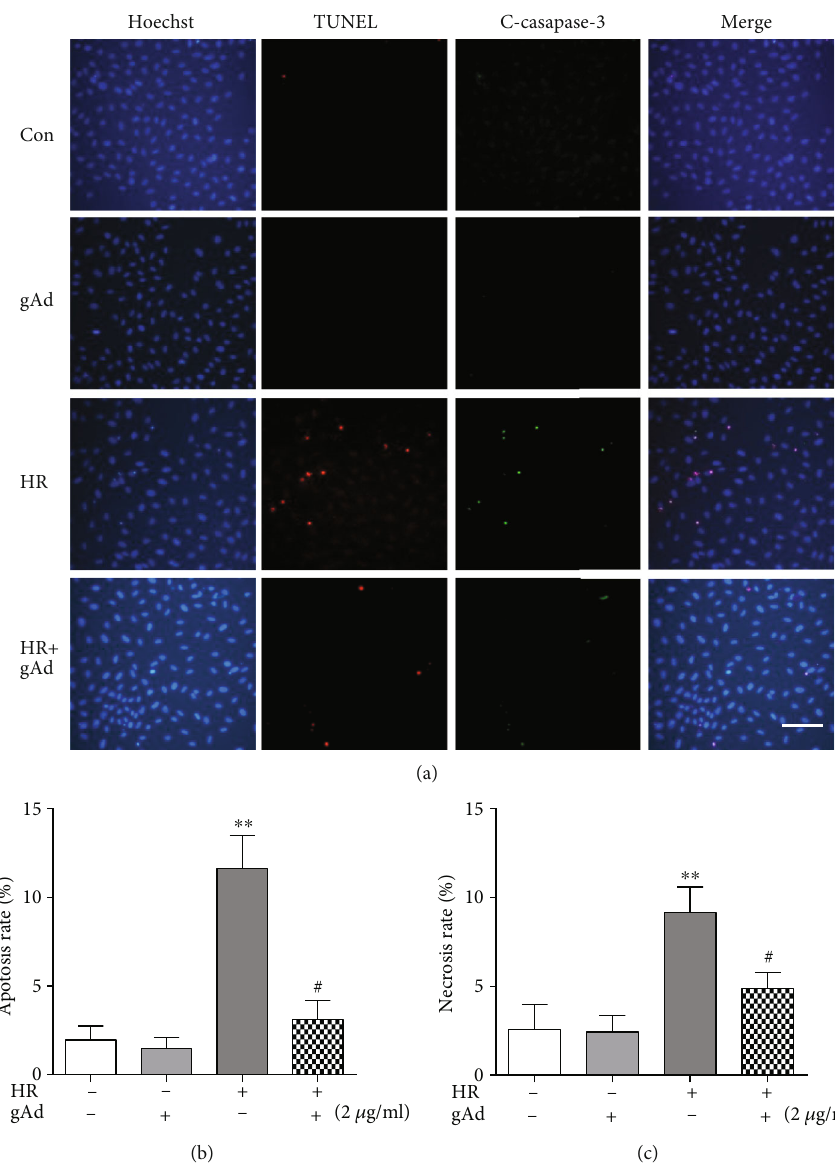
Figure 2: gAd protected NRVM cells against hypoxia/reoxygenation-induced cell death. (a) TUNEL (red) and cleaved caspase-3 (green) staining, in immuno fl uorescent images, was performed, and nuclei were stained with Hoechst 33342 (blue), which showed that apoptotic and necroptotic cells were increased after hypoxia/reoxygenation. Cells positive for both cleaved caspase-3 and TUNEL were apoptotic, whereas cleaved caspase-3-negative but TUNEL-positive cells were considered to be necroptotic (scale bar, 20 μ m). (b, c) The bar graph shows the average data for apoptotic and necroptotic cells ( n = 10 ). ∗∗ P < 0 : 01 vs. the control group; # P < 0 : 01 vs. the H12/R12